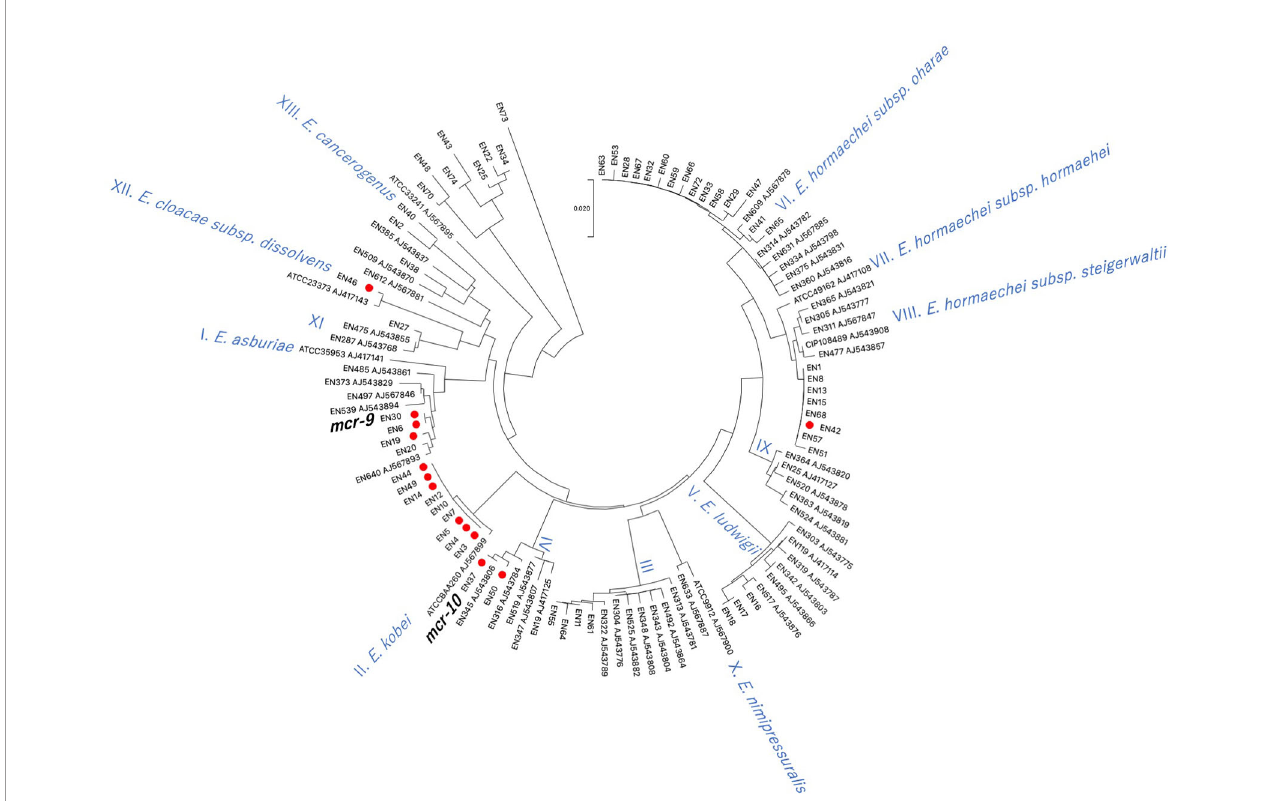
FIGURE 3 | Phylogenetic tree based on hsp60 sequences in Enterobacter spp. isolates derived from companion animals Red circles indicate colistin-resistant isolates. Reference strains are denoted by their respective accession numbers.